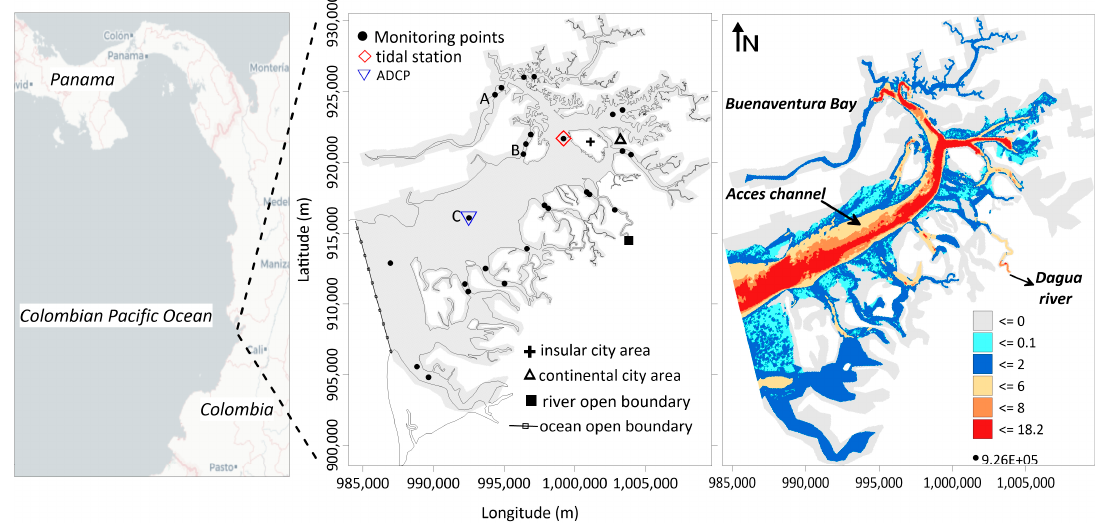
Figure 1. Study area, location of monitoring points and domain of the 3D-hydrodynamic model. Coordinates in Magna Sirgas Colombia West unit system. The labels A (Aguadulce creek), B (Crab Island) and C (channel’s talweg) denote model monitoring points utilized for further tidal analysis. The Tidal station and ADCP measurements have the coordinates 77.08079 W/3.891239 N and 77.146 W/3.837 N, respectively.